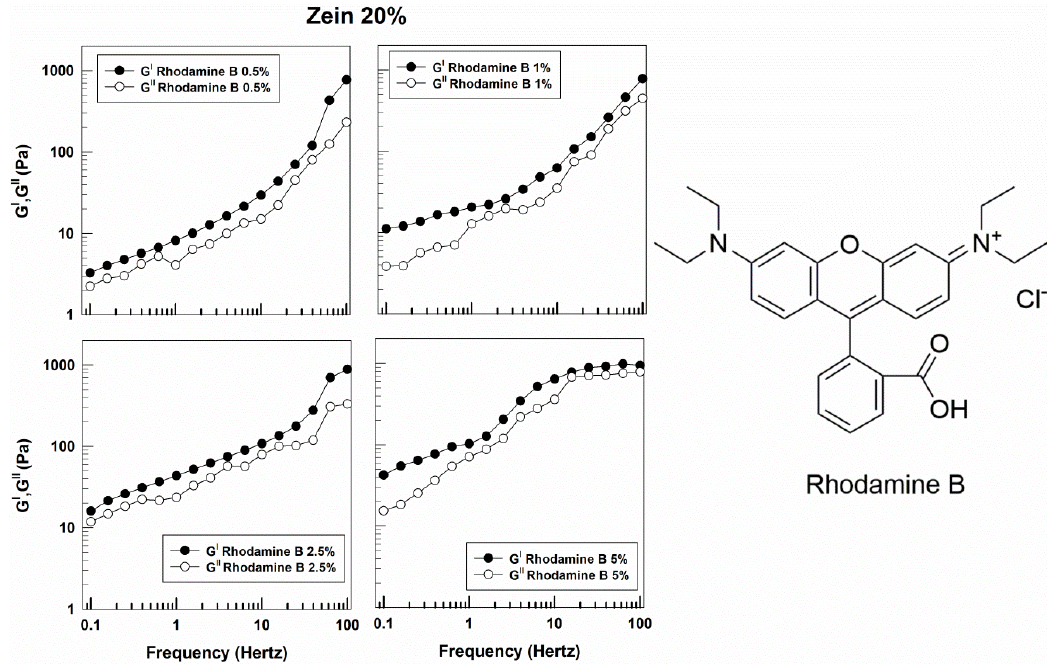
Figure 4. Evaluation of the elastic (G ′ ) and viscous (G ′′ ) moduli of zein gels prepared using 20% w/v of protein and containing rhodamine B (0.5%, 1%, 2.5%, 5% w/w ) as a function of the frequency.